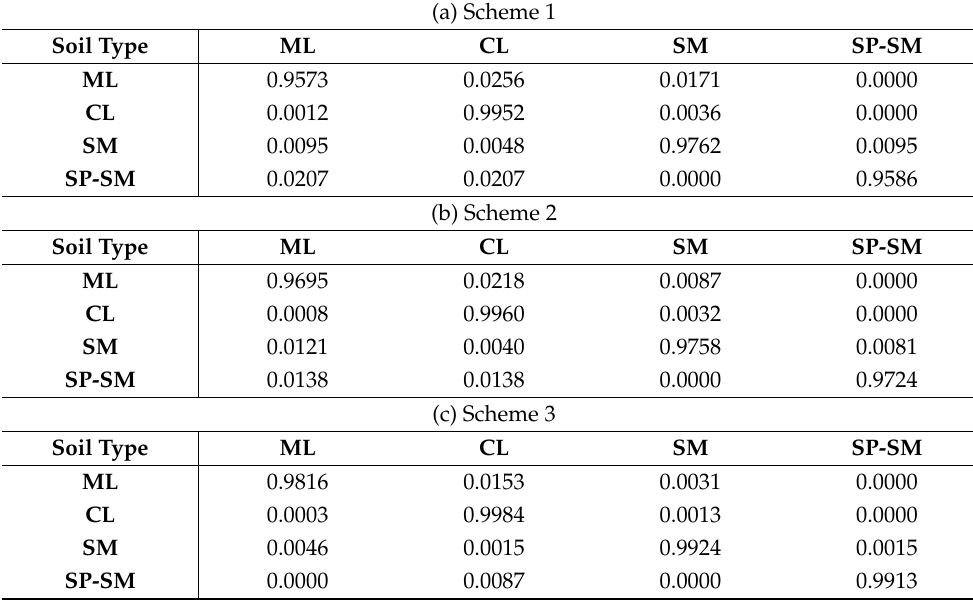
Table 5. The estimated HTPMs for various borehole